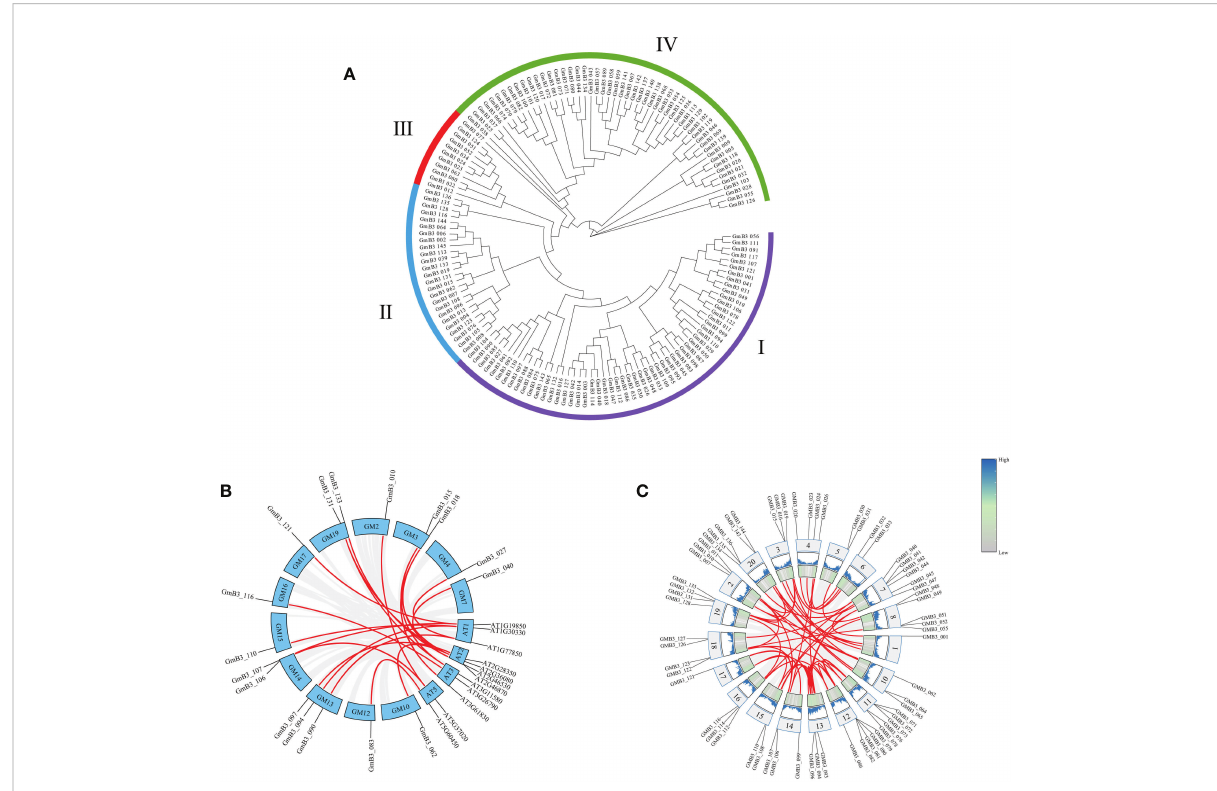
FIGURE 5 The phylogenetic tree of B3 members and collinear analysis of GmB3s. (A) Phylogenetic analysis of GmB3 genes. (B) Collinear map of B3 genes between soybean and Arabidopsis . (C) Collinear map of different GmB3 genes in